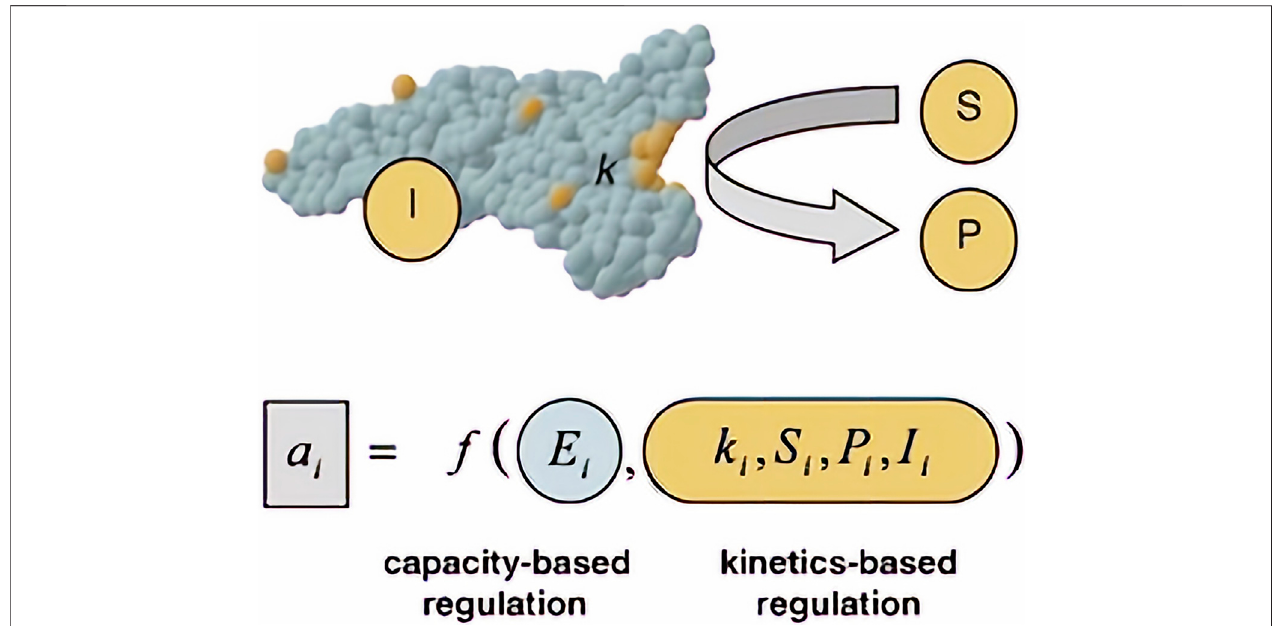
FIGURE 3 | Observed fl ux/activity a of a reaction step I. Adapted with permission from (Dauner, 2010).